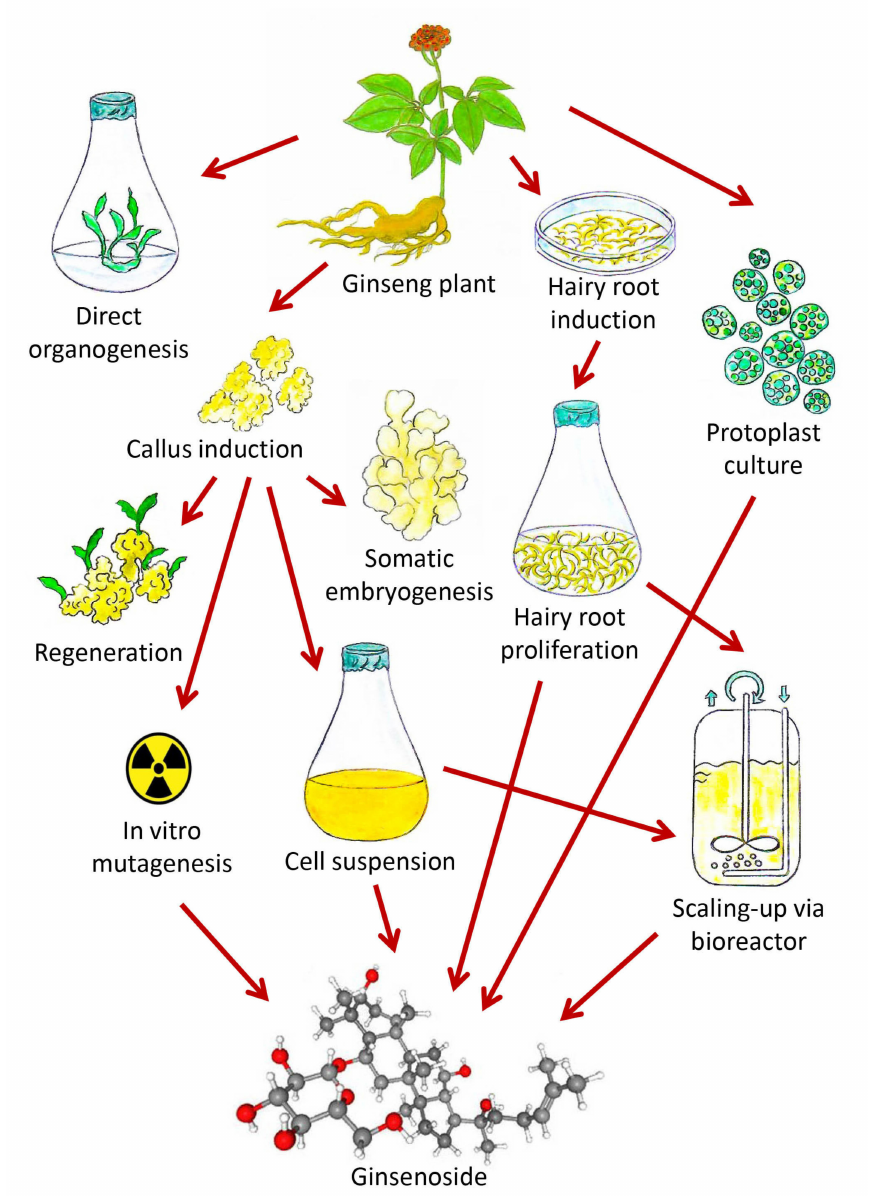
Figure 3. Diagram showing the enhanced production of ginsenosides through various in vitro biotechnological approaches (Source: unpublished photograph of Saikat